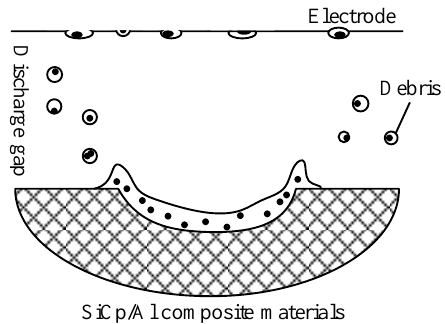
Figure 1. The process of solidification process for molten material.